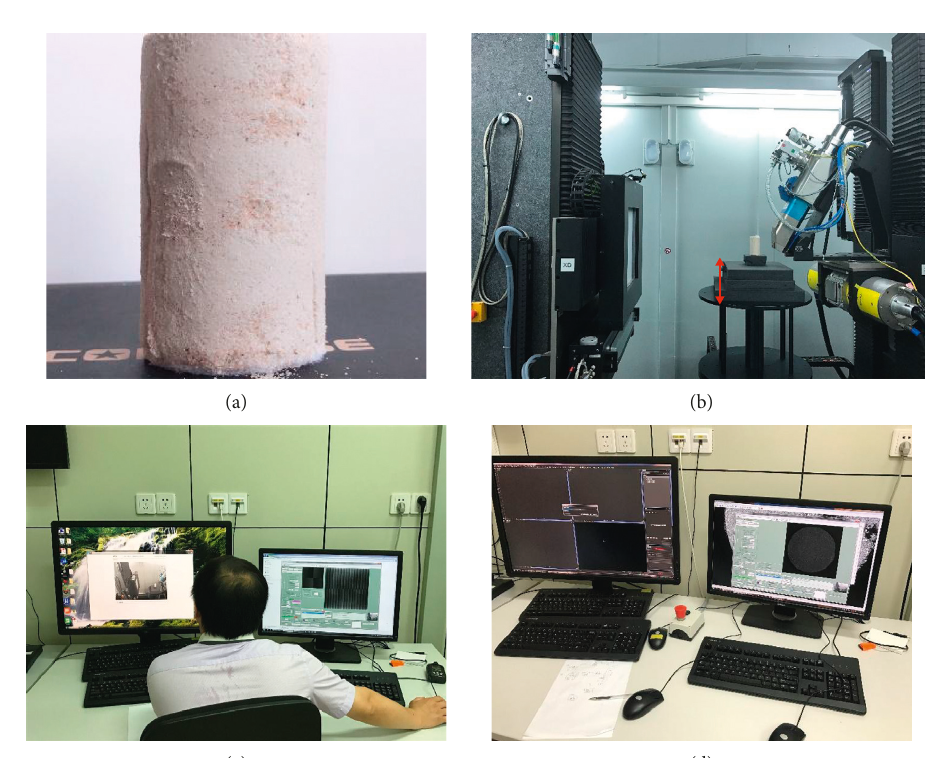
Figure 2: The micro-XCT experimental process. (a) Test sample selection, (b) placing and adjusting the sample position, (c) setting the parameters and scanning the sample, and (d) feature